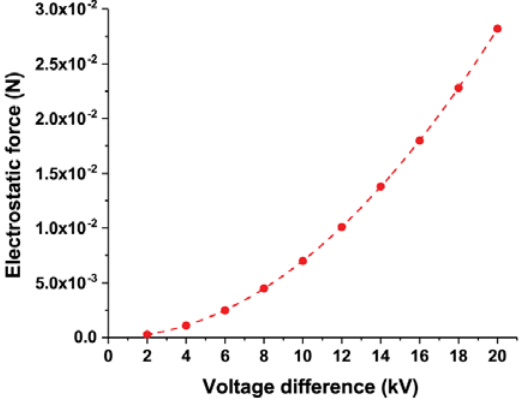
Figure 7. Electrostatic force changes due to variation in voltage difference.